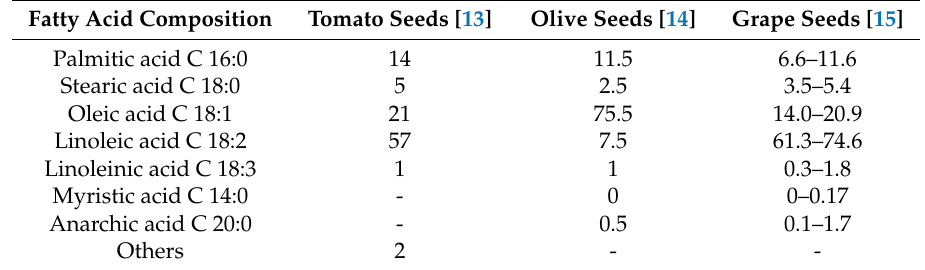
Table 2. Fatty acid Composition of biomass, obtained by mechanical extraction (%W/W